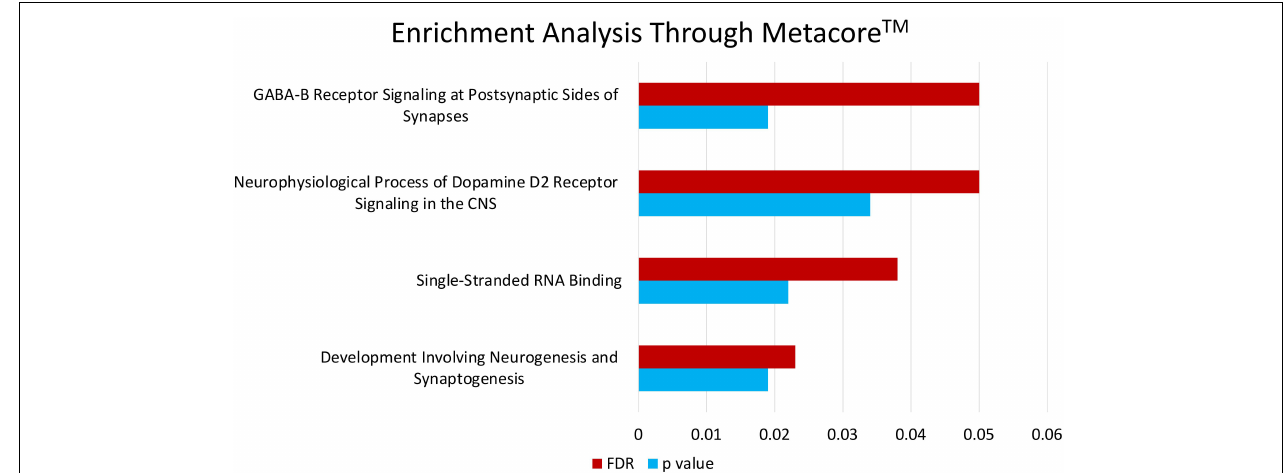
FIGURE 7 | Enrichment analysis through Metacore TM . Enrichment analysis of the SNPs that compose the fasting insulin rPRS shows that this subset of SNPs is significant for certain nervous system development processes: neurophysiological process of GABA-B receptor signaling at postsynaptic sides of synapses